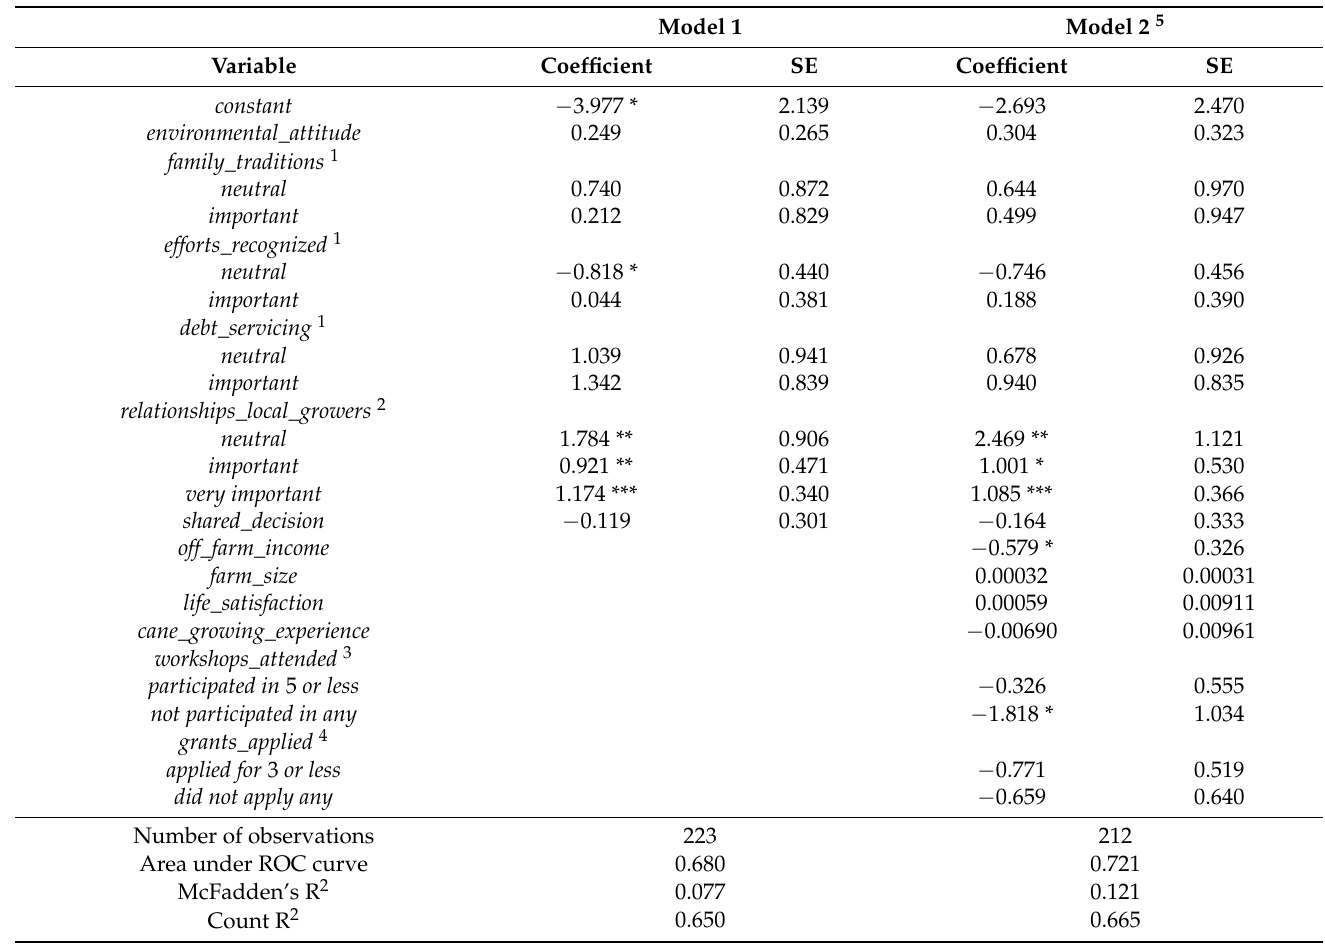
Table 2. Logistic regression results for Model 1 (only TPB constructs included as independent variables) and Model 2 (all independent variables included). Dependent variable: